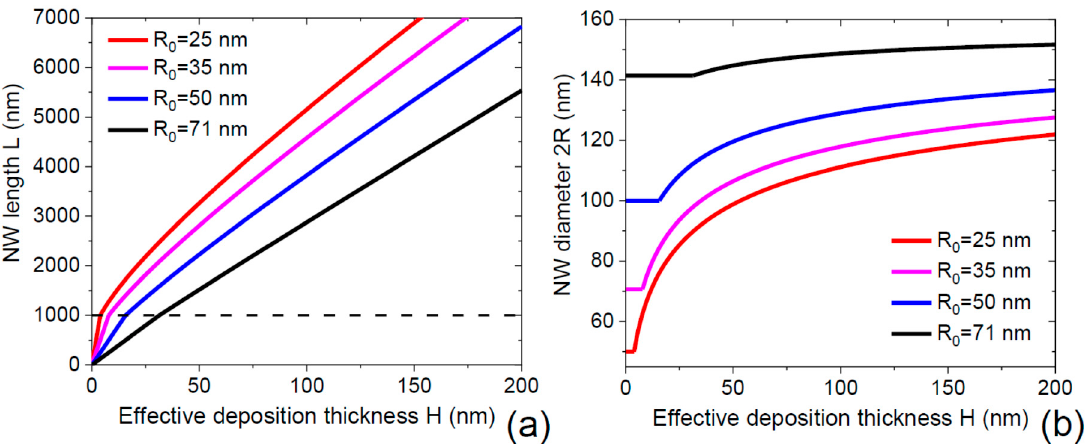
Figure 3. NW length ( a ) and diameter ( b ) versus H at a fixed λ of 1000 nm (indicated by the dashed line in ( a )) and N = 2 × 10 8 cm − 2 , for different initial NW radii R 0 indicated in the legends. The NW lengths increase linearly with H below 1000 nm and sub-linearly above 1000 nm. The NW diameters stay constant below 1000 nm length and increase above 1000 nm length, converging to the same stationary diameter at H → ∞ . This focusing effect is expected to narrow the diameter distribution within an ensemble of NWs having different initial